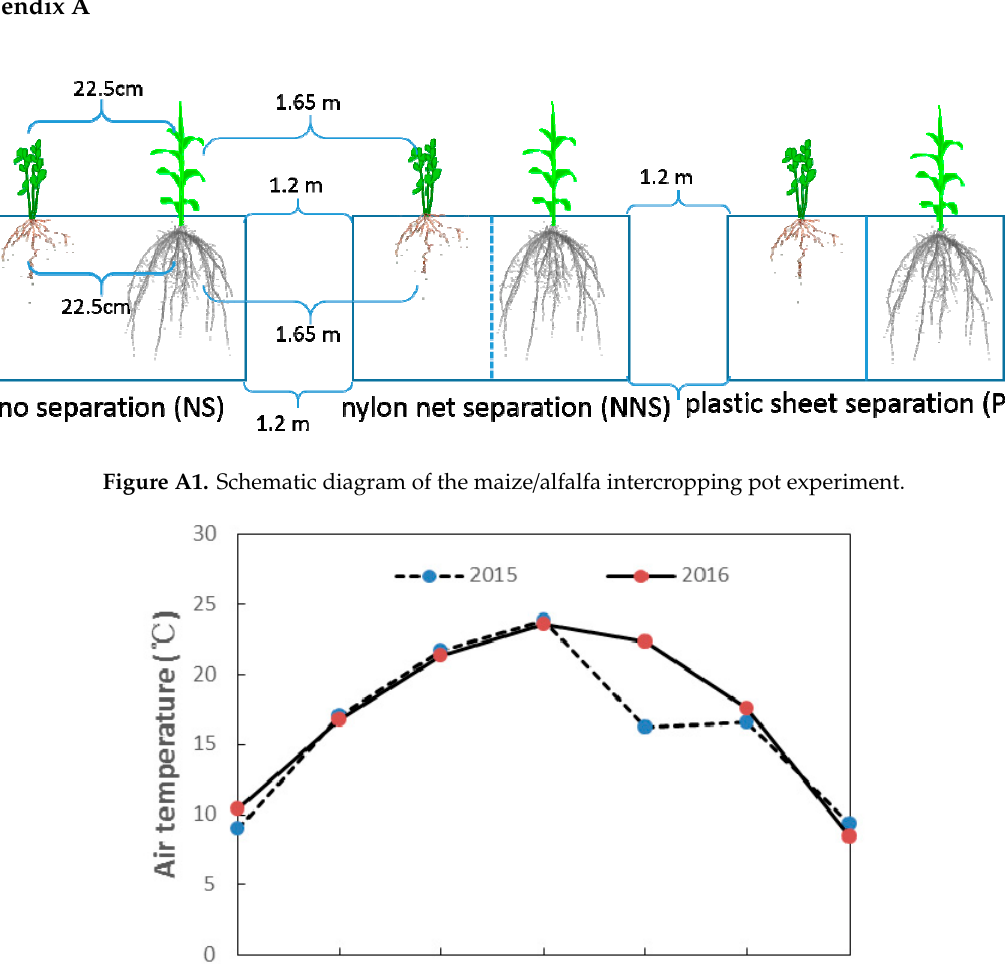
Figure A2. Air temperature (curve) of the experimental site in 2015 and 2016.